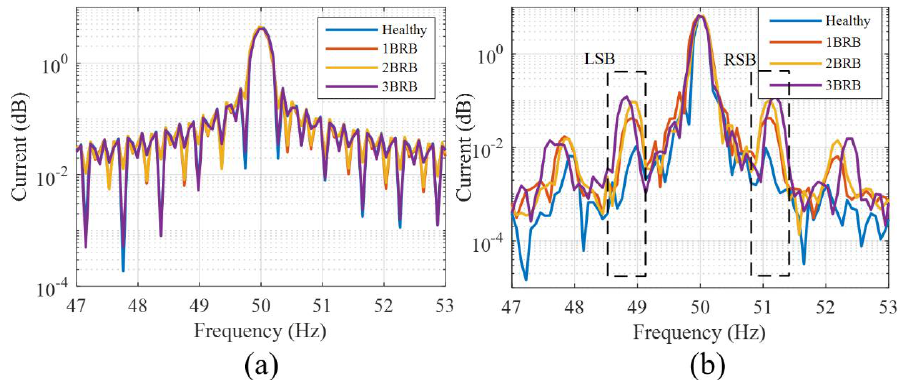
Figure 8. The frequency spectrum from 47 Hz to 53 Hz under healthy and broken rotor bar cases under steady state and ( a ) no-load and ( b ) rated-load conditions.